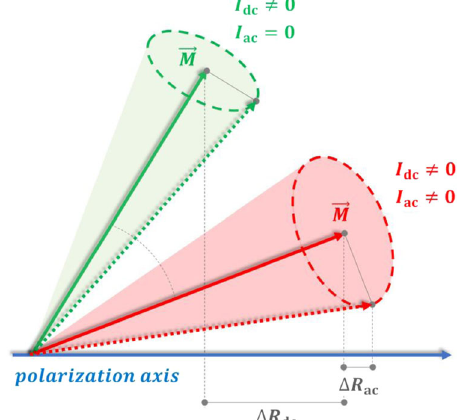
Fig. 4 | A near-cartoonish depiction of the two mechanisms originating the ampli fi cation in the MTJ at low input power. The I dc drives the self-oscillation state with an average magnetization M that changes in presence of the additional I ac . The difference of the two projections of the average magnetization into the polarizationaxisgiverisetothe Δ R dc : Additionally,the I ac .changestheamplitudeof the oscillating resistance Δ R ac